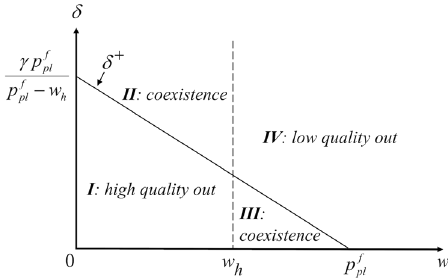
Fig. 5 Producer decisions in Scenario III. This fi gure graphs the producer net returns for Scenario III. In this scenario, the low-quality and high-quality products coexist in the market, with the high-quality product produced by more ef fi cient producers.